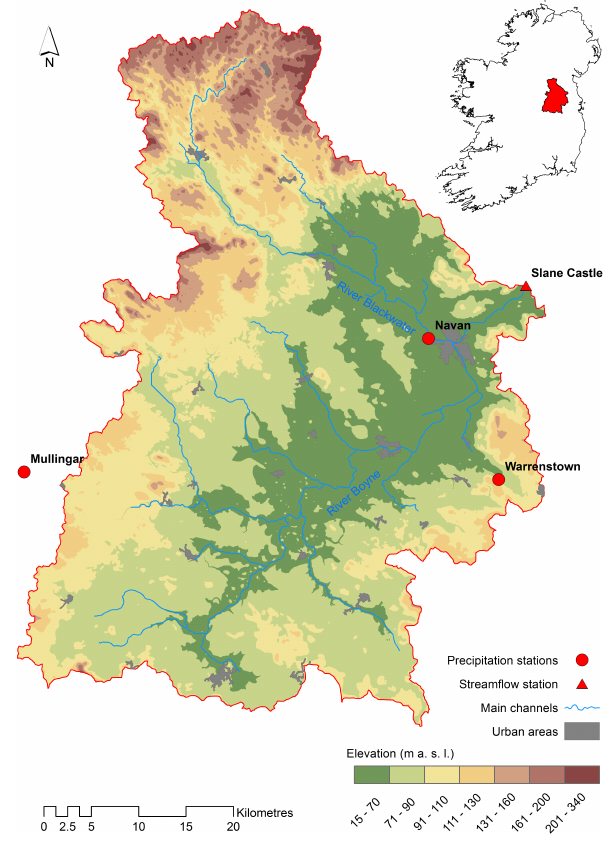
Figure 2. Boyne catchment showing major urban areas, streamflow and precipitation